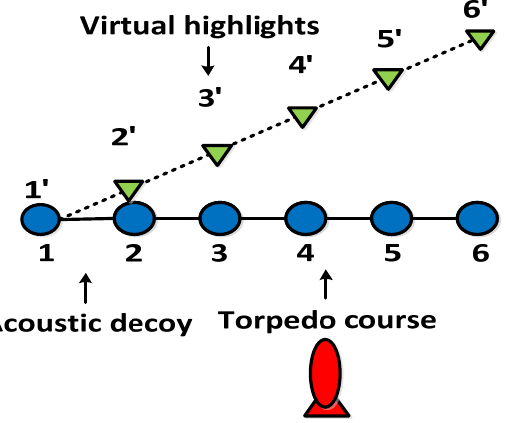
Figure 3. The mobile acoustic decoy simulating multi highlight scale targets.